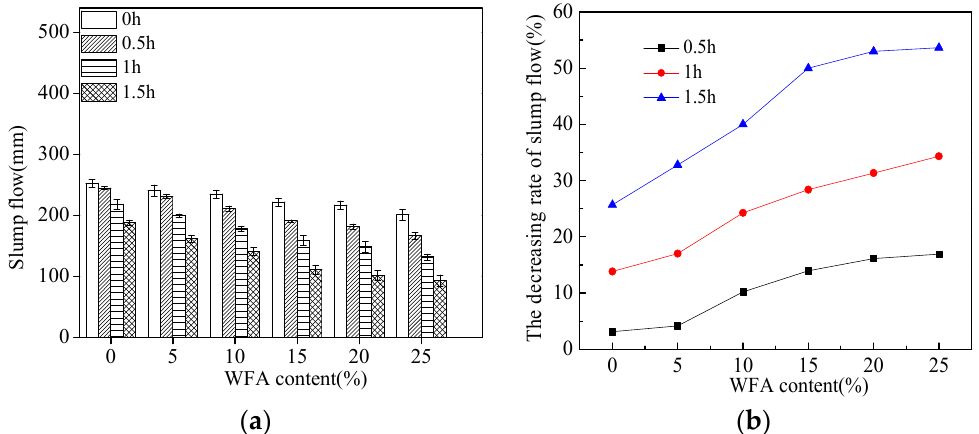
Figure 3. The slump flow of fresh cement paste with different dosages of waste fly ash. ( a ) The slump flow of fresh paste, ( b ) the decreasing rate of slump flow.